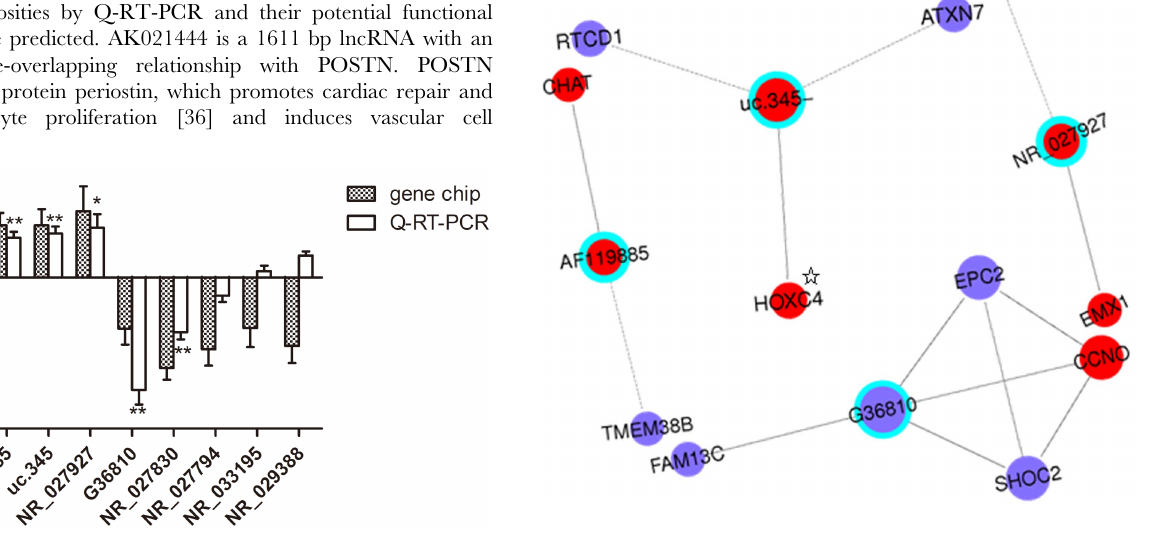
Figure 2. Coding-non-coding gene co-expression network of the four lncRNAs. The network represents co-expression correlations between the four lncRNAs and significantly differentially expressed mRNAs. Only co-expression gene pairs with Pearson coefficient (|r|) . 0.99 are shown. Four separate networks were constructed. They are displayed together in this figure. Gene nodes with a cyan node lines represent lncRNAs and gene nodes without node lines represents a protein-coding RNA (mRNA). Red nodes represent up-regulated RNAs, and blue nodes represent down-regulated RNAs. Solid lines between two nodes indicate positively correlated interactions between RNAs, and dotted lines indicate negatively correlated interactions. Node size represents the node degrees. q indicates protein coding RNA tran- scribed from natural antisense strands of the gene HOXC4.